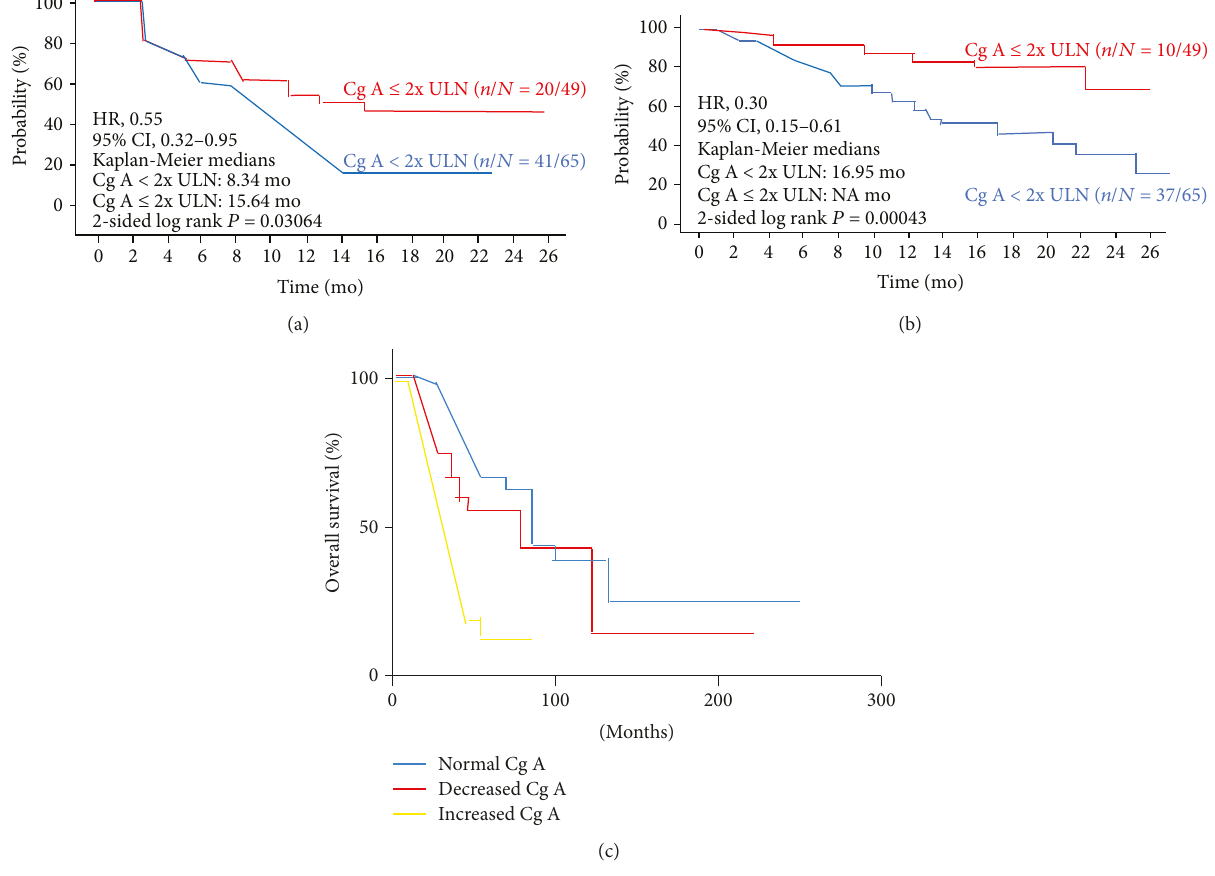
Figure 2: Early Cg A response as potential predictor of treatment outcome. In the RADIANT-1 study, patients with early Cg A response experience longer median progression-free survival (13.31 months) (a), whereas median overall survival is 24.90 months (b) [82]. A study in patients with NF-pNETs shows that a reduction of Cg A concentration is correlated with better prognosis in this group of patients (c)